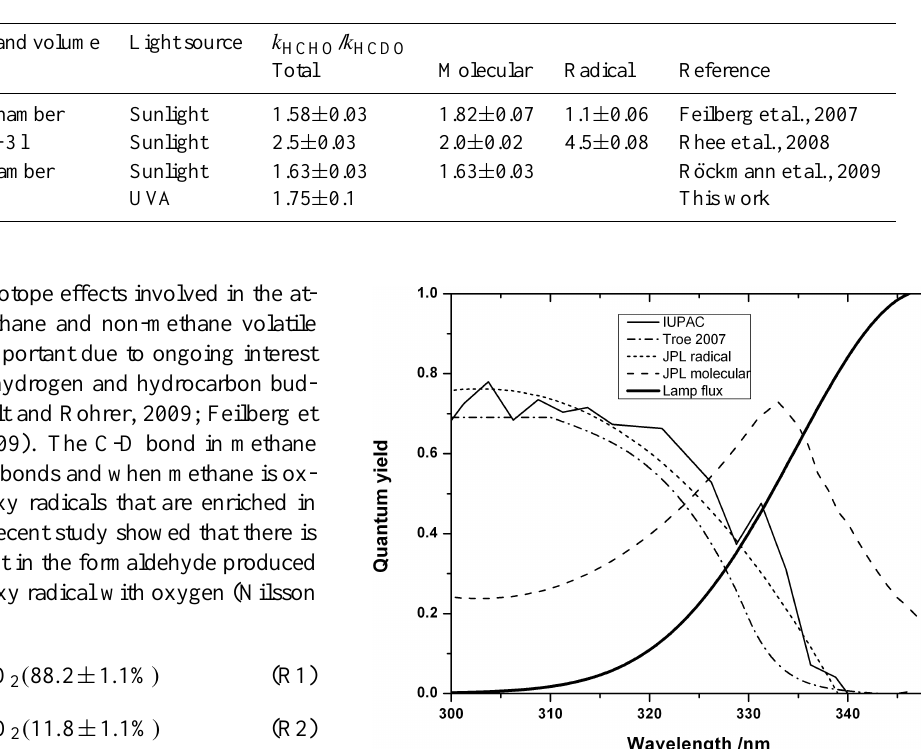
Table 1. Summary of previous experimental result, and the results obtained at 1030mbar in this study.